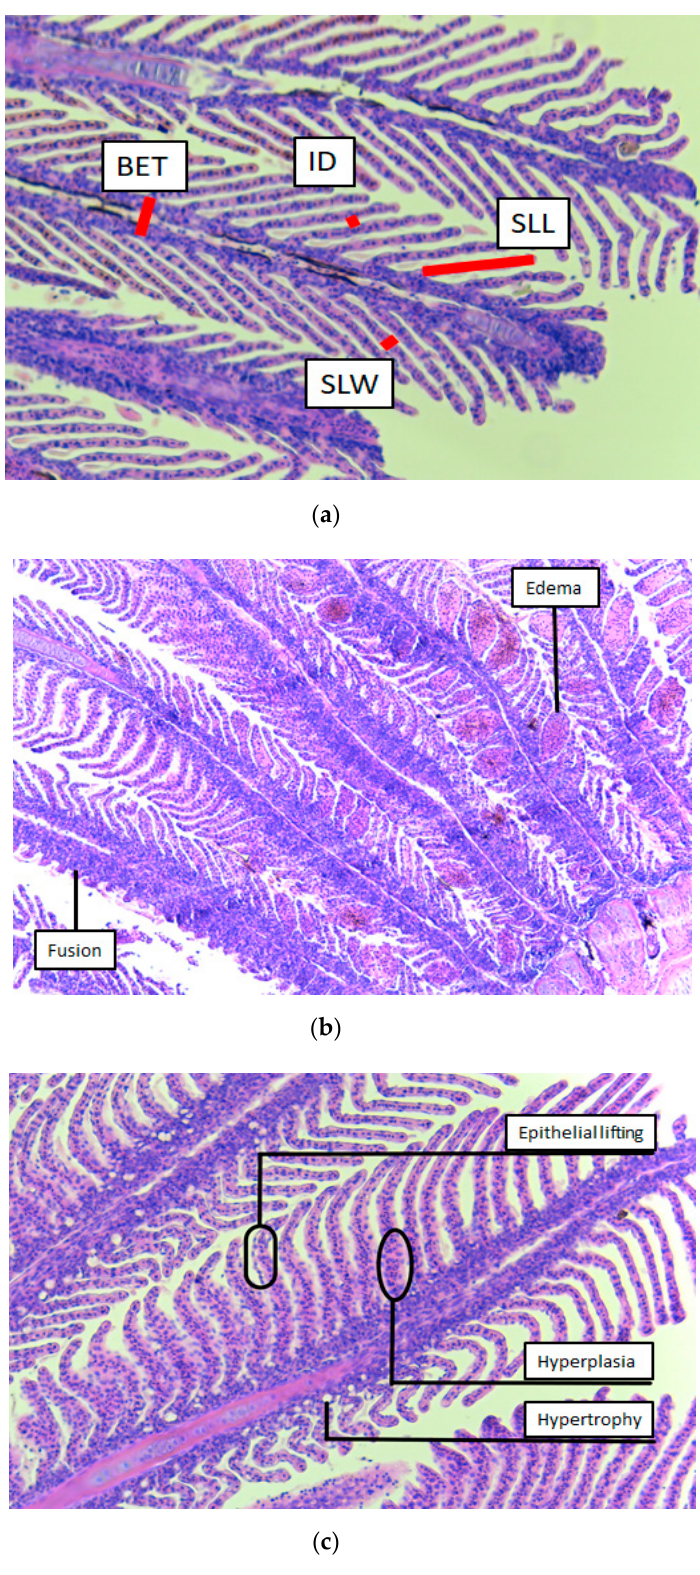
Figure A2. ( a ) Sample of morphometric measurements of the gill. BET, basal epithelium thickness; ID, interlamellar diameter; SLL, secondary lamellar length; SLW, secondary lamellar width. ( b , c ). Examples of the gill pathologies that were scored. Five pathologies were scored out of a scale from 1–4 for severity and summed, where ( b ) shows edema and fusion of the secondary lamellae and ( c ) shows epithelial lifting, hyperplasia, and hypertrophy. See methods and Table A1 for descriptions of the